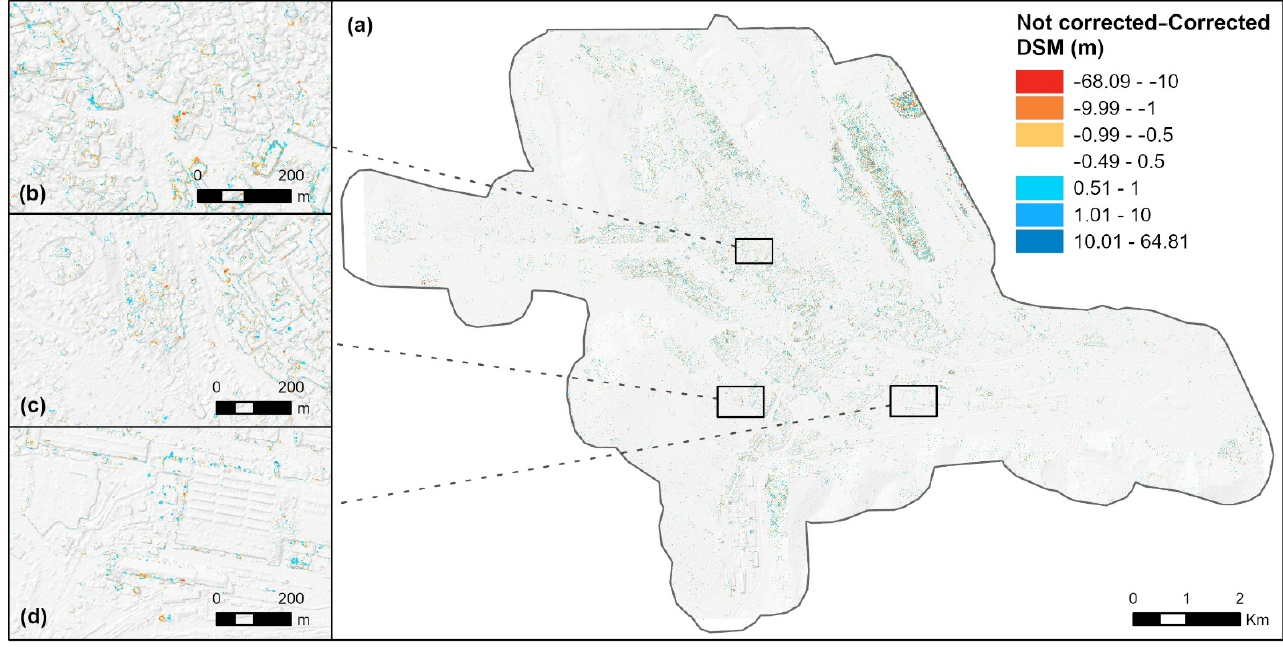
Figure 20. ( a ) Difference raster between the two scenarios for DSM, not corrected and corrected, and detailed view over ( b ) a central part of the city, ( c ) a residential hilly area and ( d ) an industrial site.